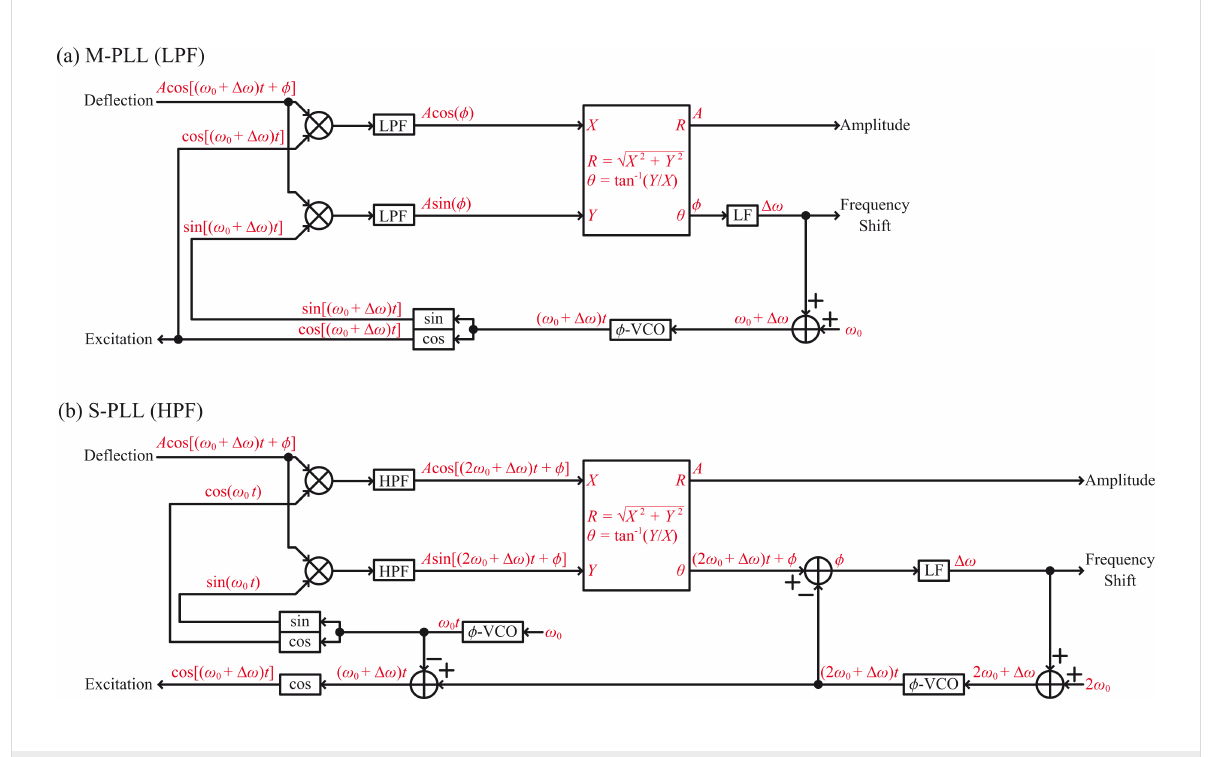
Figure 3: Block diagrams of the implemented (a) M-PLL and (b)